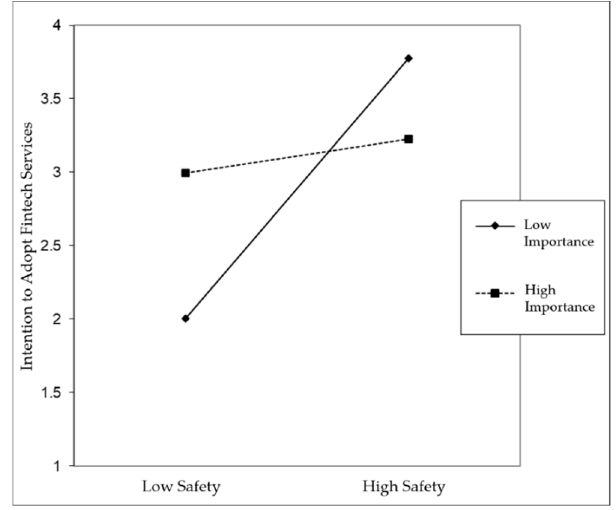
Figure 5. Interaction Perception of Importance of the characteristics of Fintech Services × Perception of Security of Fintech Services (Source: Microsoft Excel 365).